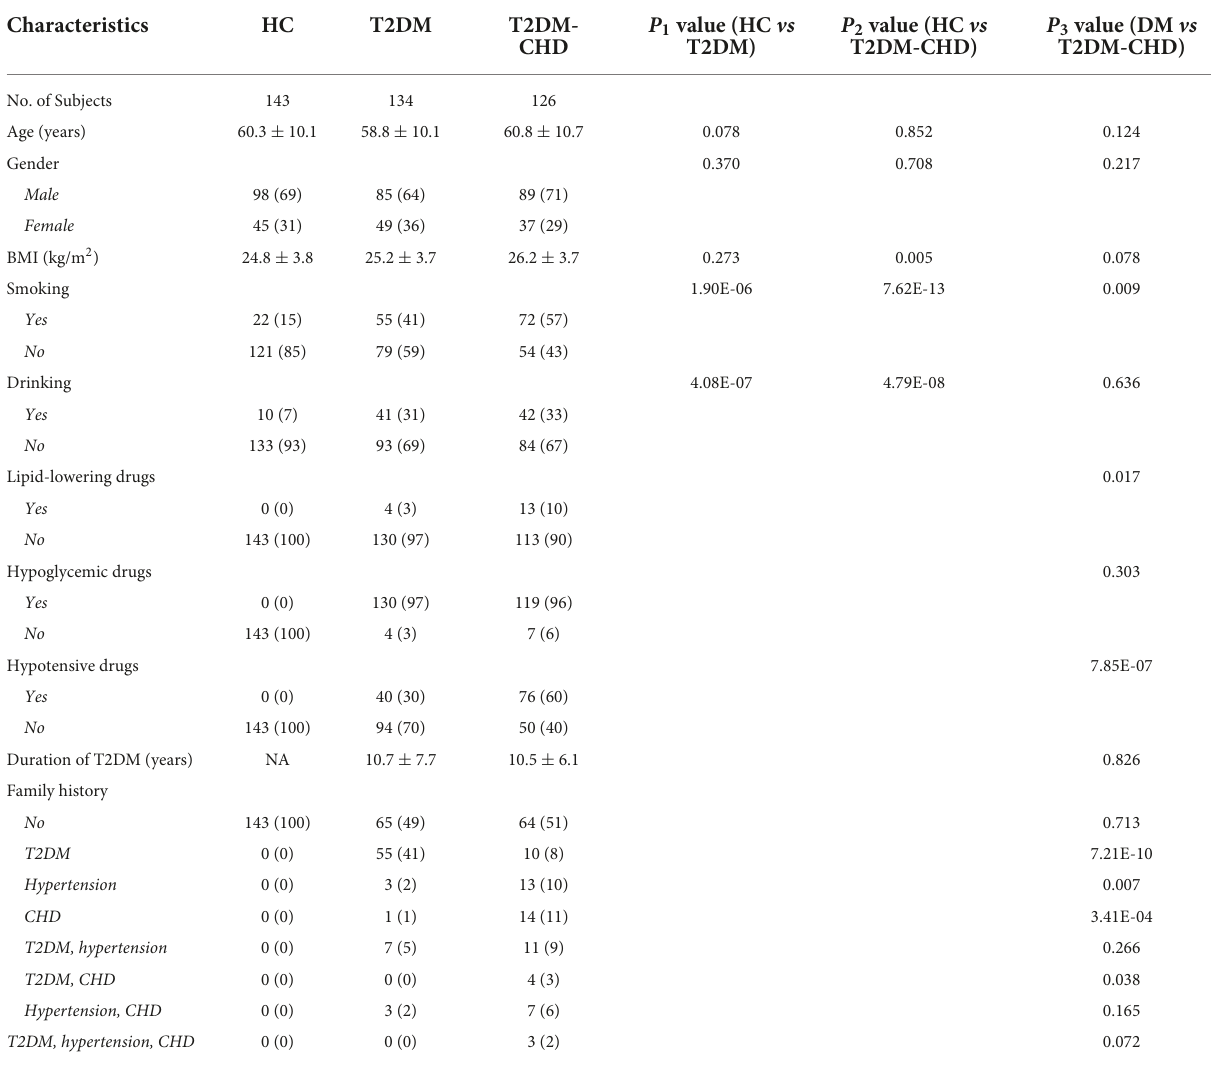
TABLE 1 Demographic and clinical characteristics of the